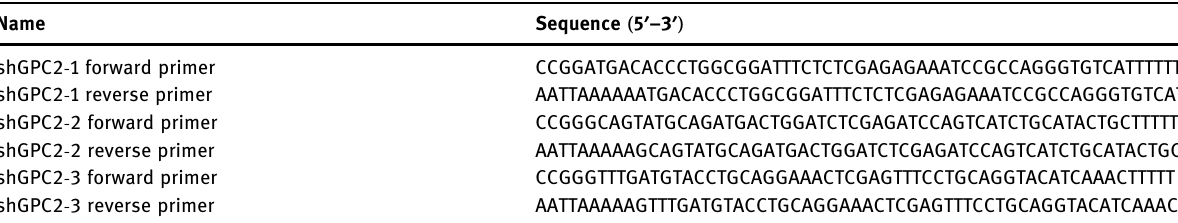
Table 1: The primers for constructing plasmids